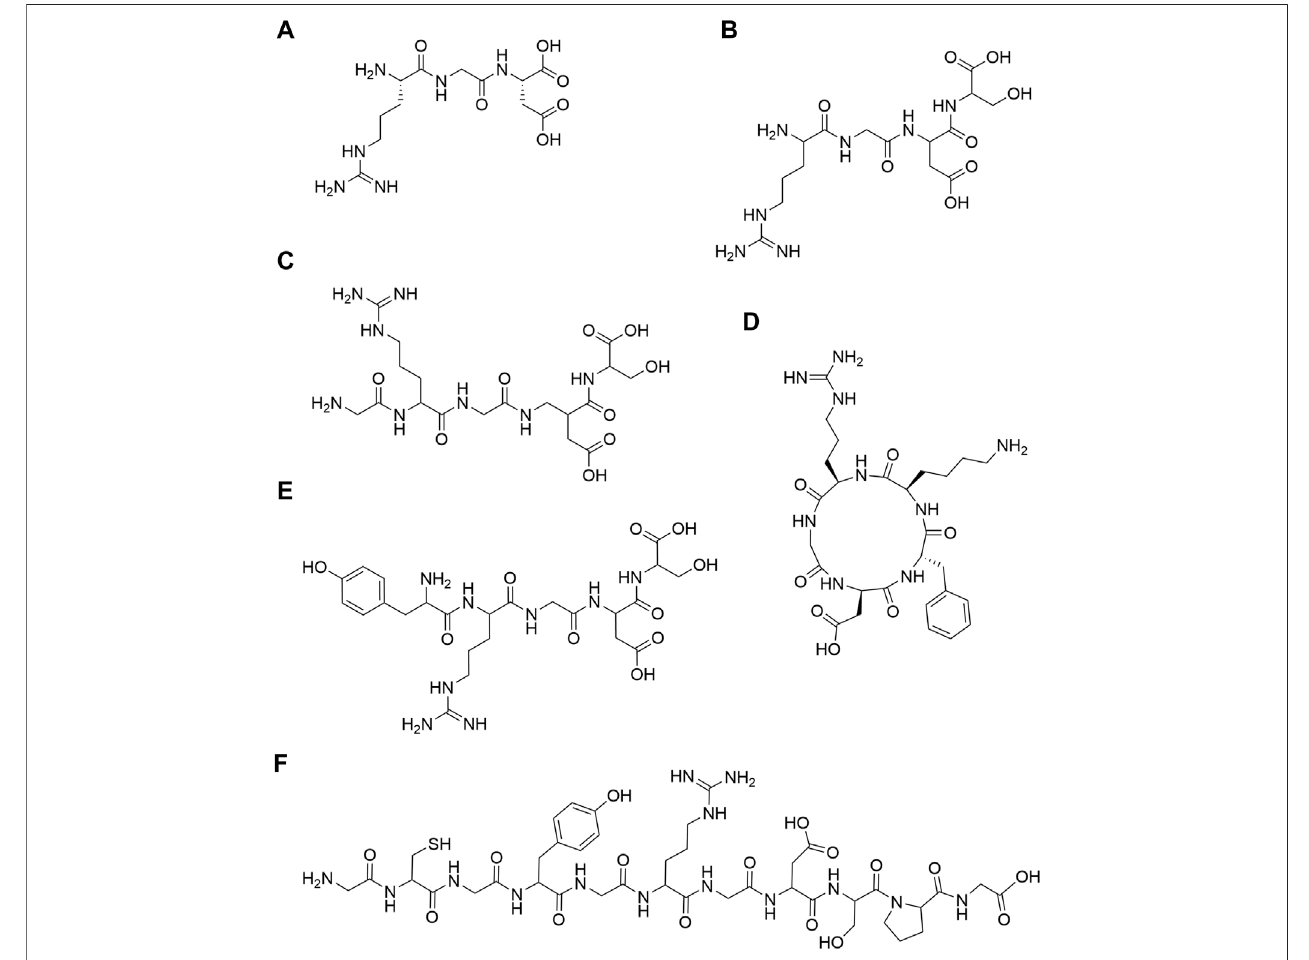
FIGURE 1 | Chemical structures. (A) RGD; (B) RGDS; (C) GRGDS; (D) c (RGDfk); (E) YRGDS; (F)